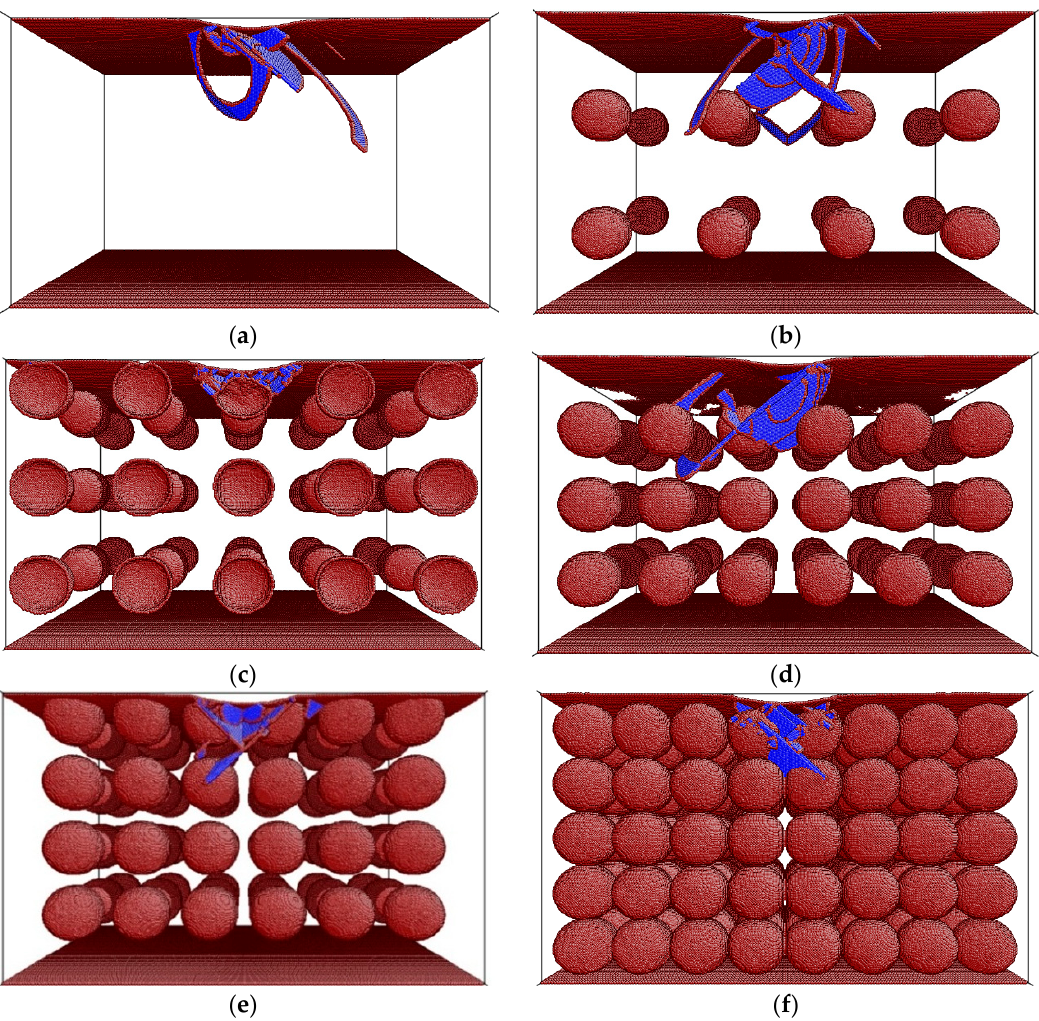
Figure 3. Snapshots showing the dislocation structure at a constant penetration depth ( h s = 15 Å) of spherical MD indentation simulations on (001) Cu single crystals for: ( a ) bulk; ( b ) p = 5%; ( c ) p = 10%; ( d ) p = 15%; ( e ) p = 20%; ( f ) p = 45%. The pore size in panels ( b – f ) is fixed to D p = 8 nm. Dark red color designates atoms with a reduced coordination number.